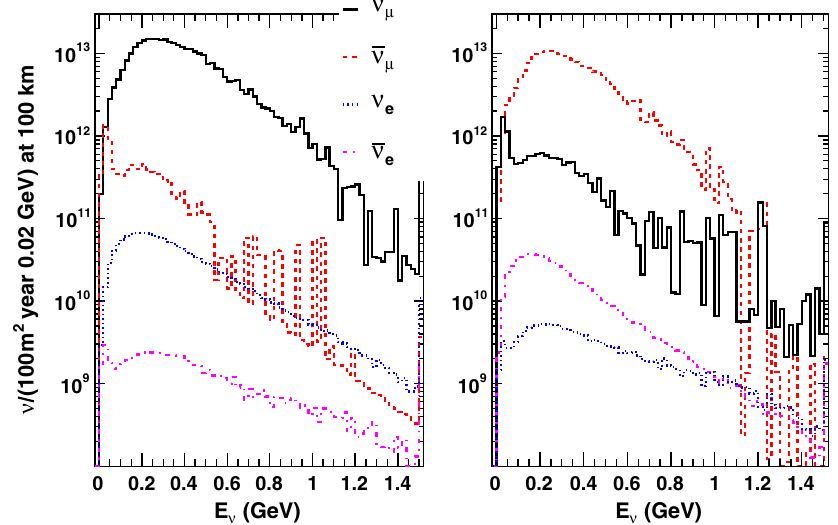
FIG. 29. Nonoscillated neutrino fluxes obtained with the optimized horn and decay tunnel in positive (left) and negative (right) focusing mode.